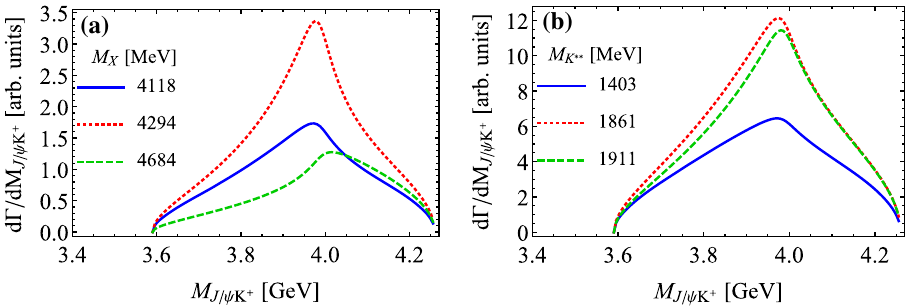
mass and width of K ∗∗ are taken to be those of K 1 ( 1400 ) (solid line), K ( 1860 ) (dotted line), and K ( 1911 ) (dashed line) given by LHCb [1],